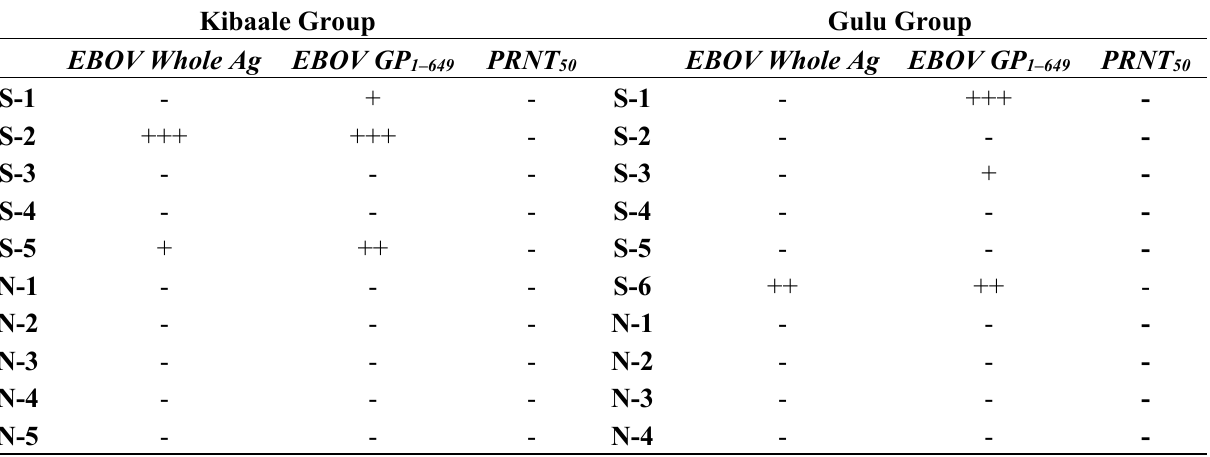
S—Ebola survivors, N—Non-infected control ELISA results were divided into low (+), medium (++) and strong (+++) immunoreactivity: (+)—(Lower than 2x cut off value), (++)—(2x cut off value—4x cut off value), (+++)—(Greater than 4x cut off value). For neutralization assay (PRNT50): (+)—(Neutralizes at 1:20 dilution), (++)—(Neutralizes at 1:40 dilution), (+++)—(Neutralizes at greater than 1:80